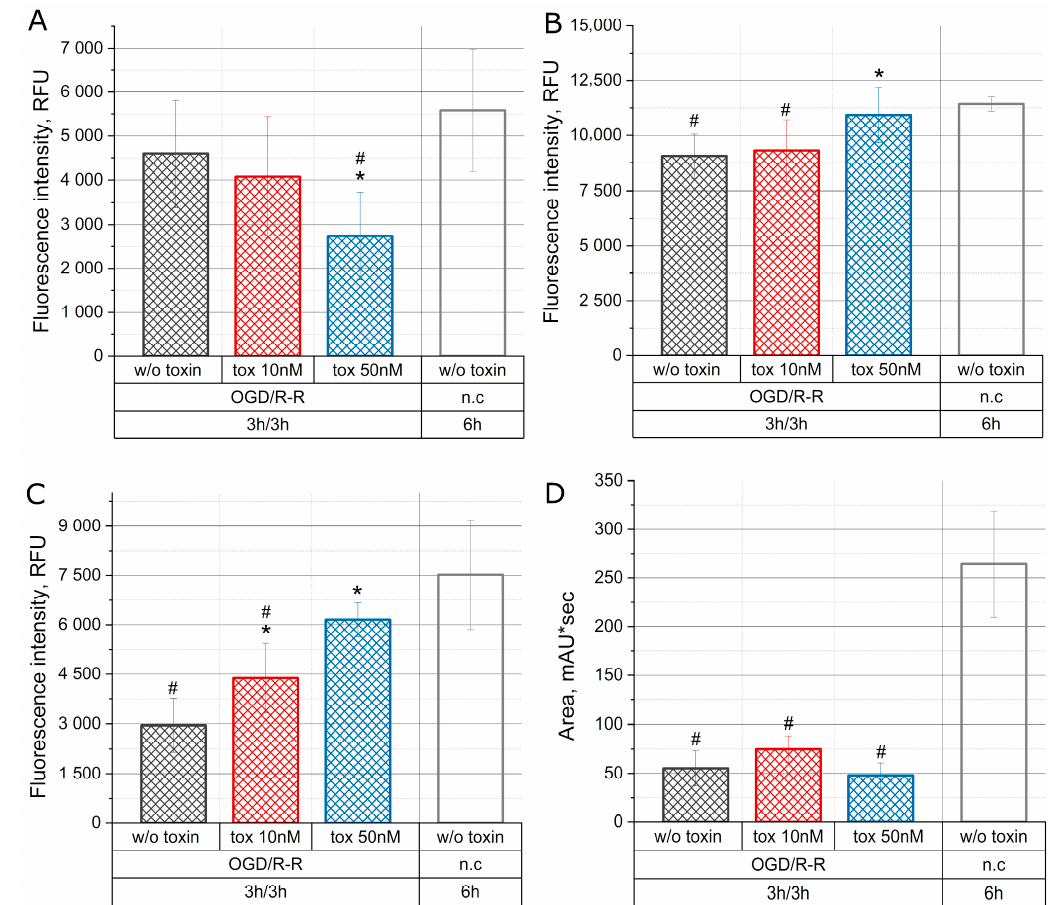
Figure 4. Change in the level of ROS ( A ), NO ( B ), mitochondrial membrane potential ( C ), and concentration of ATP ( D ) in the CHO-K1 culture with the toxin effect at concentrations of 10 nM and 50 nM under conditions of OGD/R-R (OGD—oxygen–glucose deprivation, R-R—reoxygenation-reperfusion; n.c.—normal condition); RFU—relative fluorescence units); *— p < 0.01 when compared with the “OGD w/o toxin” group, #— p < 0.01 when compared with the “n.c.”